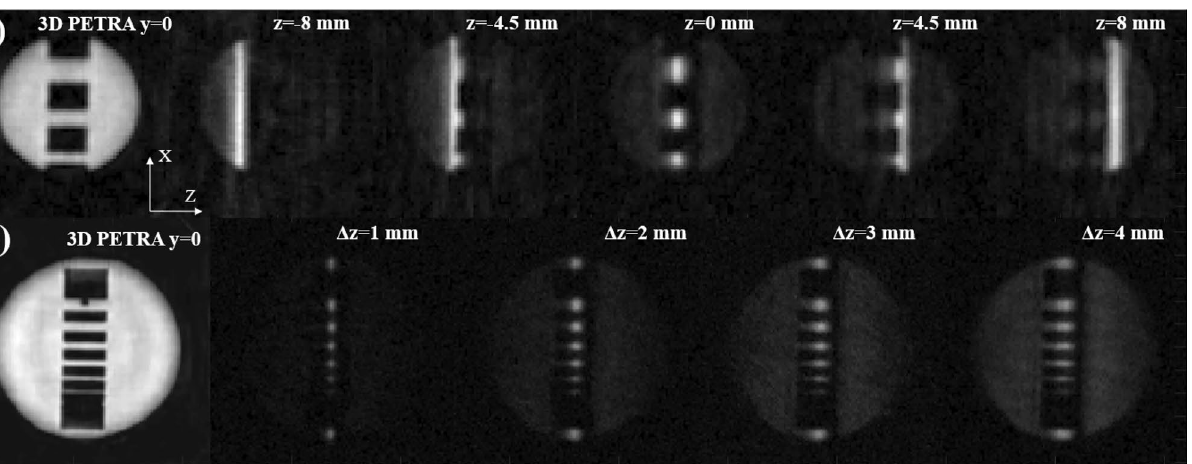
Figure 2. Control over slice selection for two PLA structured phantoms filled with 3 % CuSO 4 doped water. Leftmost images correspond to PETRA, while the rest are obtained with 3D-DiSLoP, with ( a ) slice positions z ≈ − 8 , −4.5, 0, 4.5 and 8 mm, and ( b ) slice thicknesses (cid:31) z ≈ 1, 2, 3, 4 mm.